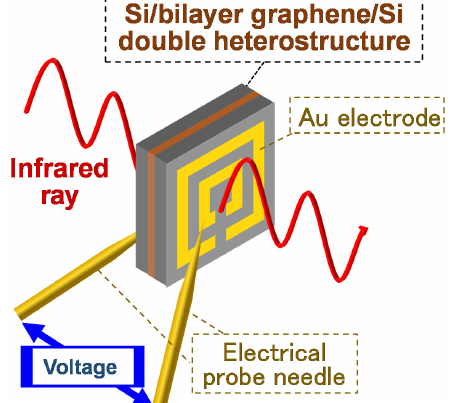
Figure 1. Conceptual drawing of the measurement system used for graphene bandgap tuning and detection.